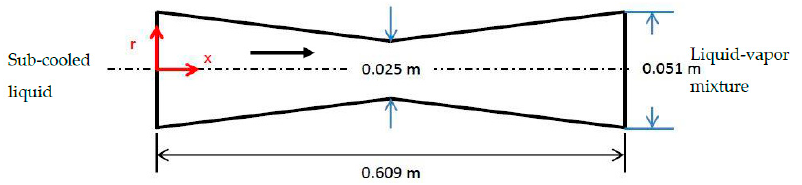
Figure 6. Circular converging-diverging nozzle used in the tests of [33].